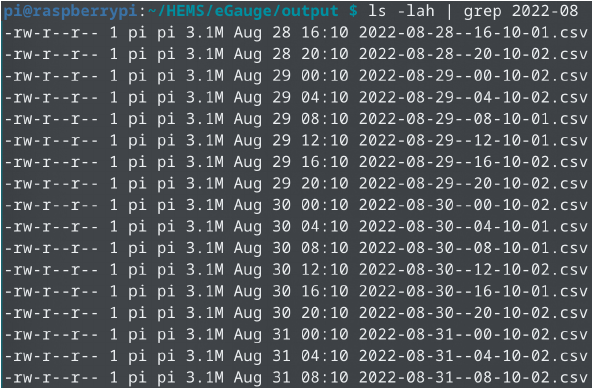
Figure A1. Smart Meter energy records from eGauge unit.